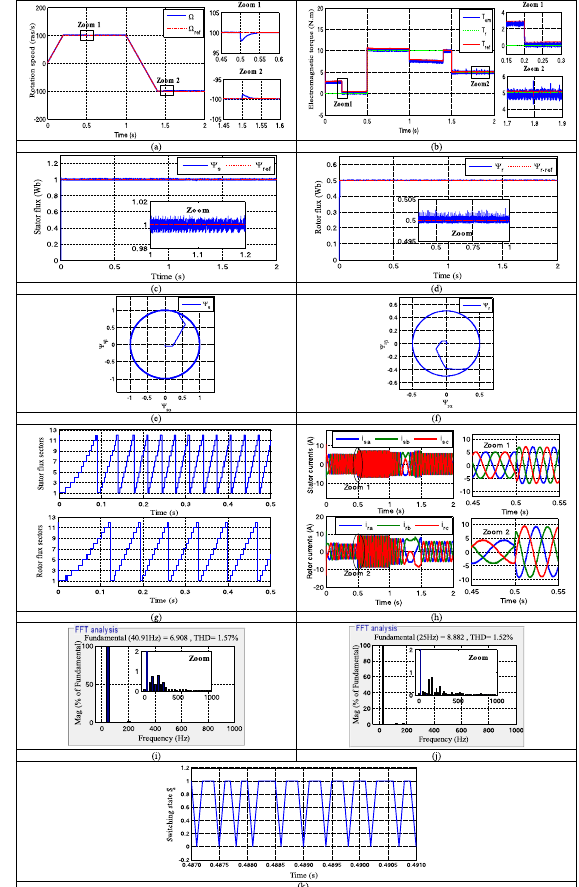
Fig. 7 Simulation results of DTC using 2LVSIs: ( a ) Rotation speed ( b ) Electromagnetic torque ( c ) Stator flux ( d ) Rotor flux ( e ) Stator flux trajectory ( f ) Rotor flux trajectory ( g ) stator and rotor flux sectors ( h ) Stator and rotor currents ( i ) FFT analysis of stator current i sa ( j ) FFT analysis of rotor current i ra